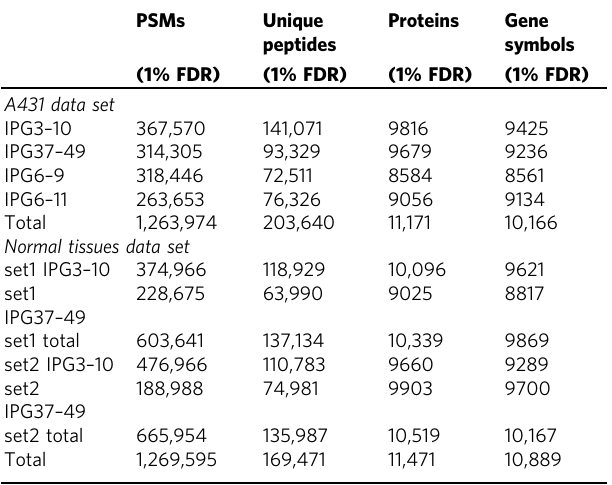
Table 1 Identi fi cation statistics from the standard proteome search